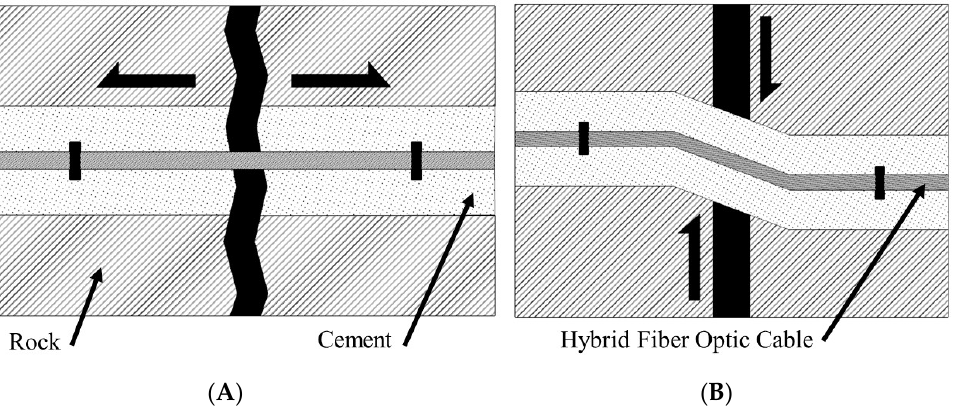
Figure 3. ( A ) Tensile and ( B ) shear displacement along a discontinuity across and grouted borehole with installed hybrid fiber optic cable.